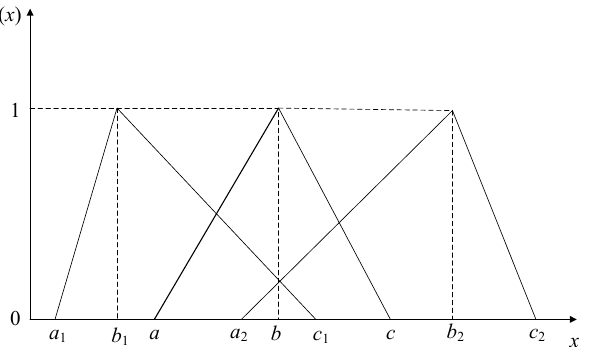
Figure 3. Example of the triangular fuzzy number: A 1 = ( a 1 , b 1 , c 1 ), A = ( a , b , c ), and A 2 = ( a 2 , b 2 , c 2 ).